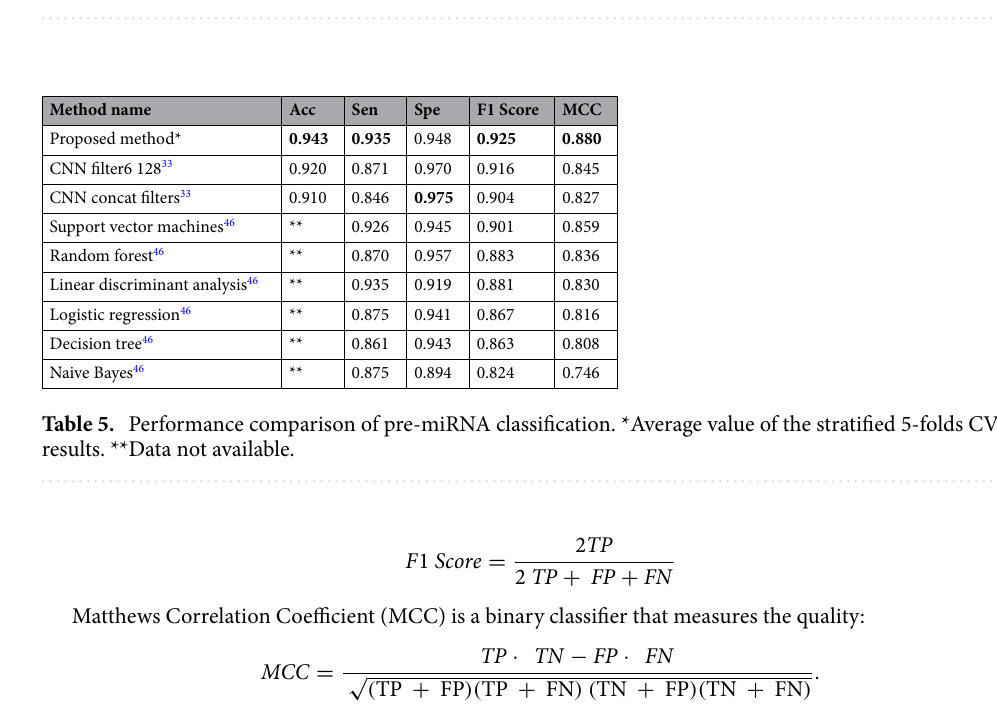
Table 4. Performance of the proposed CNN-LSTM network for each fold.